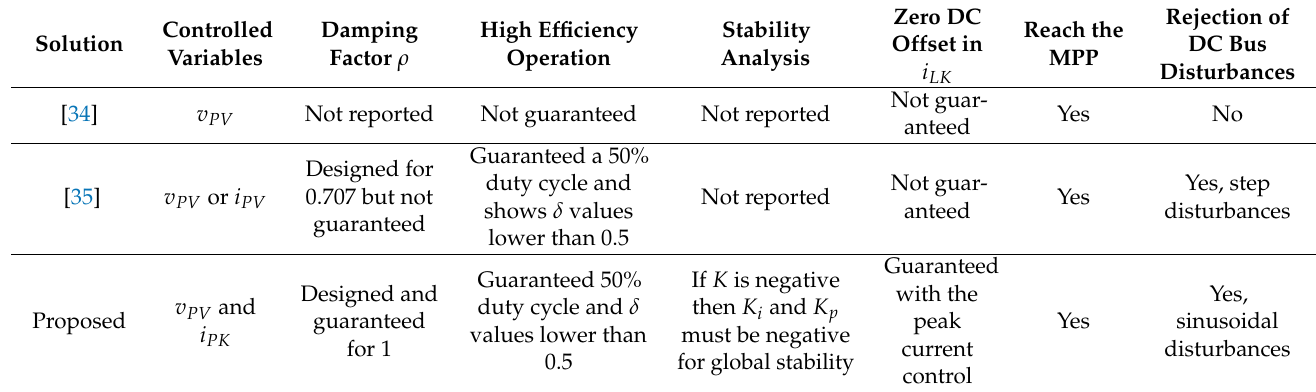
Table 1. Controller comparison for PV system based on DAB converter.